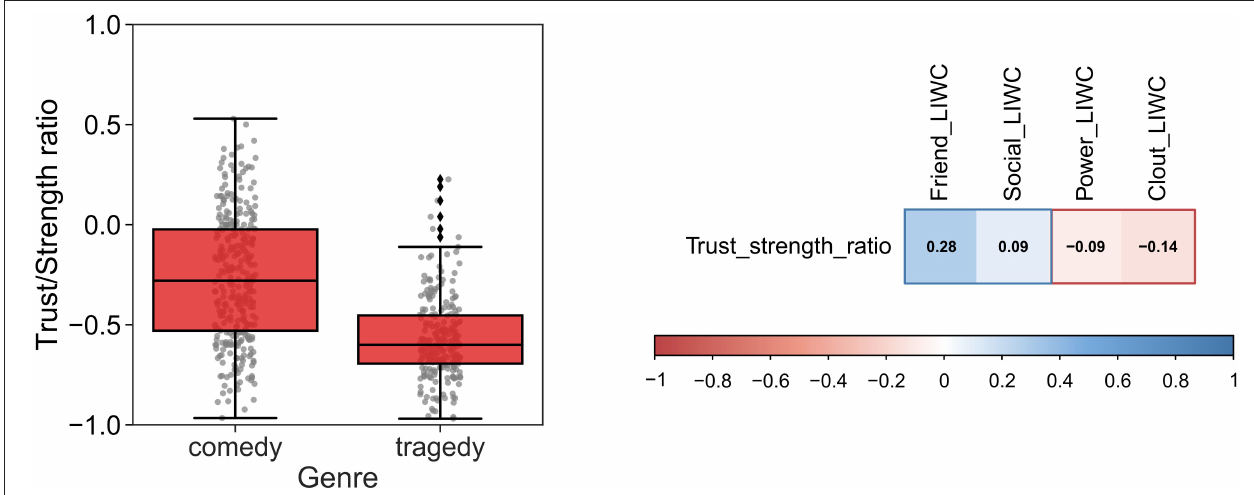
FIGURE 3 | Example of external validation techniques. (left) correct distinction between different types of text (the mean ratio Trust/Strength is significantly different between comedies and tragedies, see Martins and Baumard, 2020 for details) (right) correlation with indirect proxies from Linguistic Inquiry and Word Count